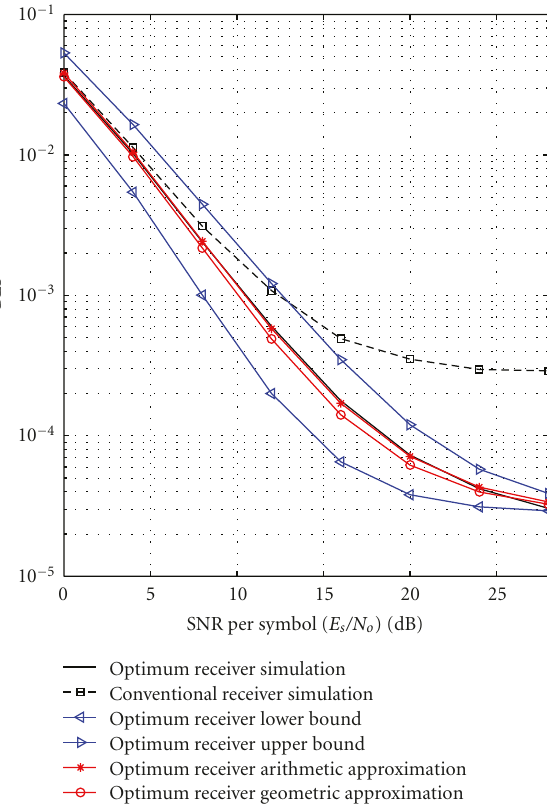
Figure 2: Case 1: BEP results for the conventional and the optimum SBS receivers, 2Tx and 2Rx Alamouti’s code with QPSK modulation, f d T b = 0 . 1, channel variances are 0.9 and 9, respectively.